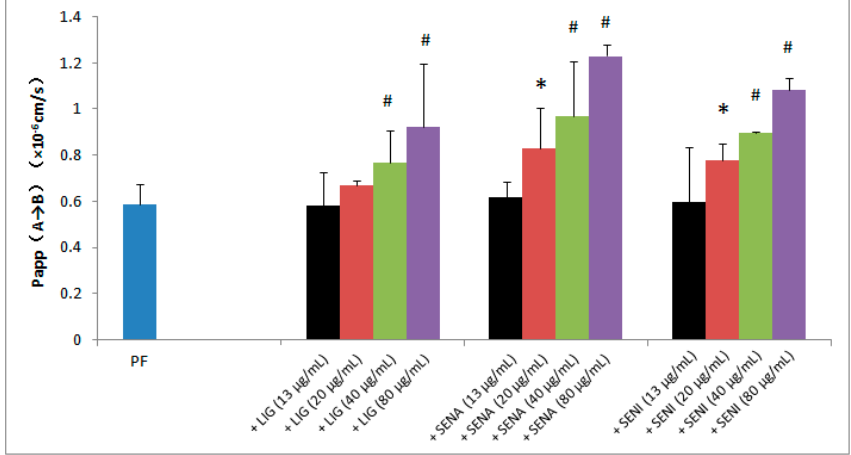
Figure 4. Effects of LIG, SENA and SENI on the transport of PF in MDCK-MDR1 cells. Papp, permeability; A, apical side; B, basolateral side. Values are mean ± SD ( n = 3). Differs from PF (400 µg/mL): * p <